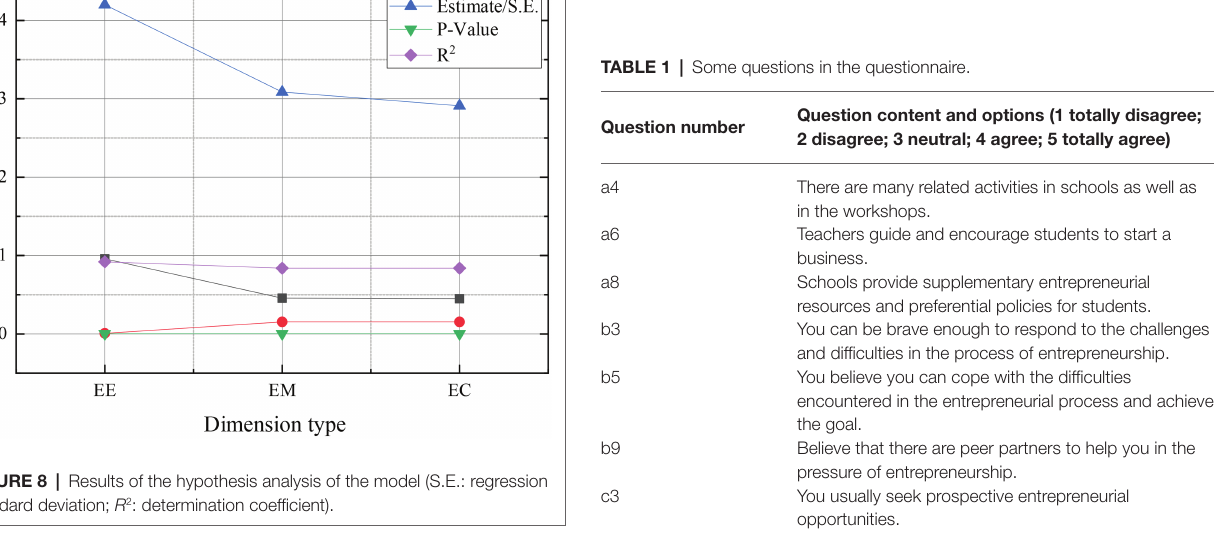
FIGURE 9 | Guidance from the analysis of foreign students’ entrepreneurial information.